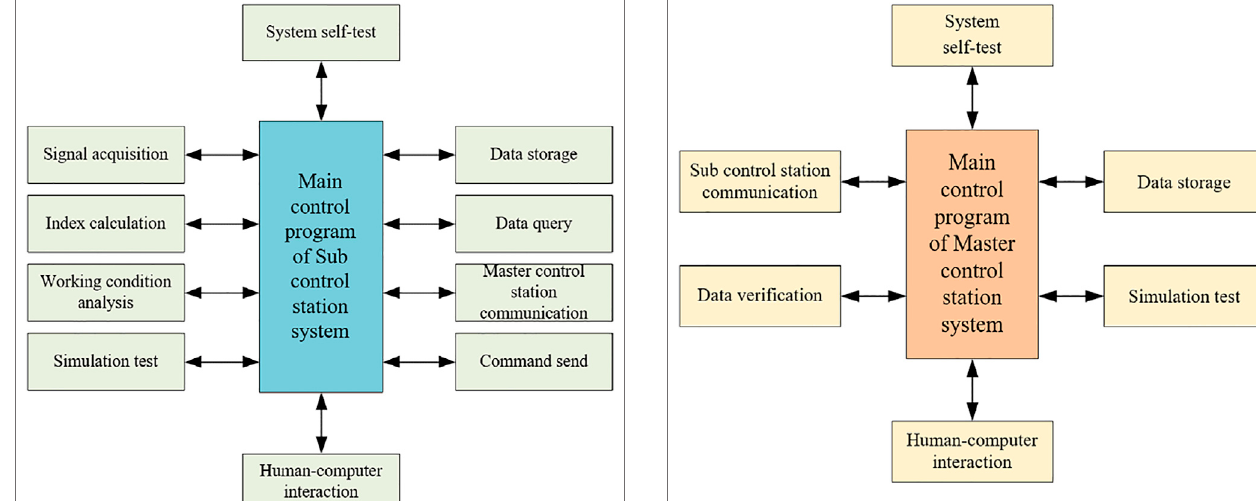
FIGURE 8 | Functional block diagram of the master control station